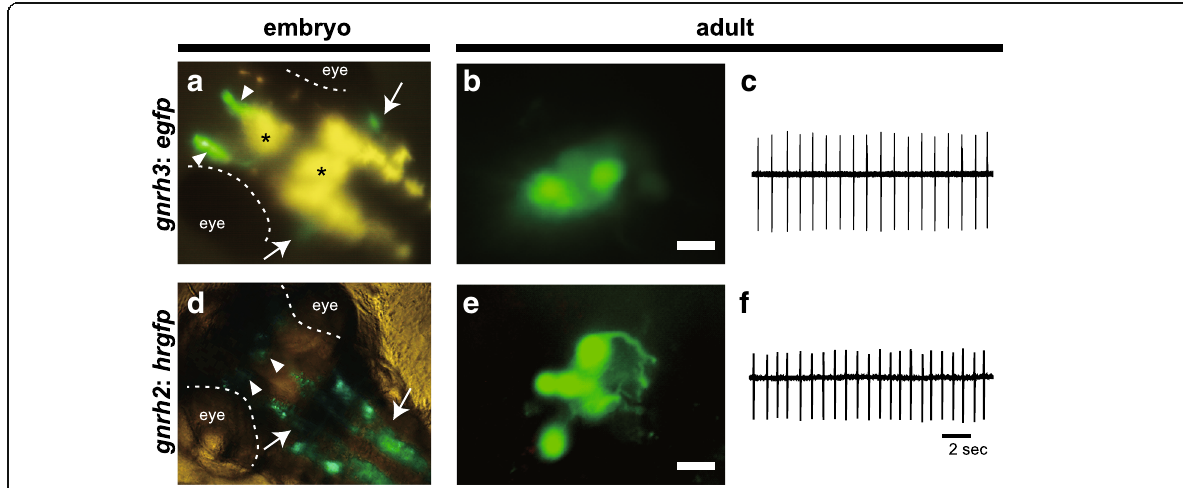
Fig. 2 Anatomical and electrophysiological characteristics of GnRH neurons in the terminal nerve and the midbrain tegmentum ( a ) A ventral view of the brain of gnrh3 : egfp medaka embryo. GFP-expressing neurons in the terminal nerve (arrowhead) and the trigeminal nerve (arrow). b Conventional fluorescence microscopic view of the cluster of terminal nerve neurons. Bar, 20 μ m. Embryos of ( a ) and ( d ) are 4~5 dpf. Yellow autofluorescence (*) originates from chromatophores of medaka body. ( c ) Spontaneous pacemaker activity of adult medaka (12.5 weeks after fertilization) recorded by a targeted on-cell patch clamp recording. ( d ) Ventral view of gnrh2 : hrgfp medaka embryo. The arrowhead indicates GnRH neurons in the midbrain tegmentum (arrowheads). Dense GFP-signals (arrow) are also observed in the spinal cord. ( e ) Enlarged view of the cell bodies, similar to B. Bar, 20 μ m. ( f ) Spontaneous pacemaker activity from a gnrh2 : hrgfp neuron in adult medaka. e & f : modified from Kanda